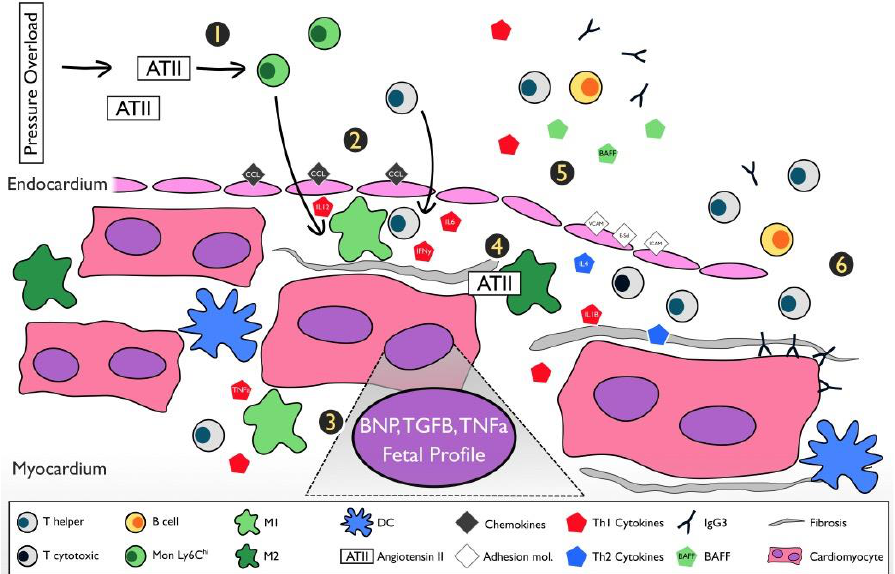
Figure 3. Summary of the PO-HF murine model. 1) Progressive PO stimulates the release of ATII. ATII stimulates mobilization of Ly6C hi monocytes from the bone marrow and spleen [30,38,40,41]. ATII and mechanical stress stimulate the expression of chemokines promoting infiltration of Ly6C hi